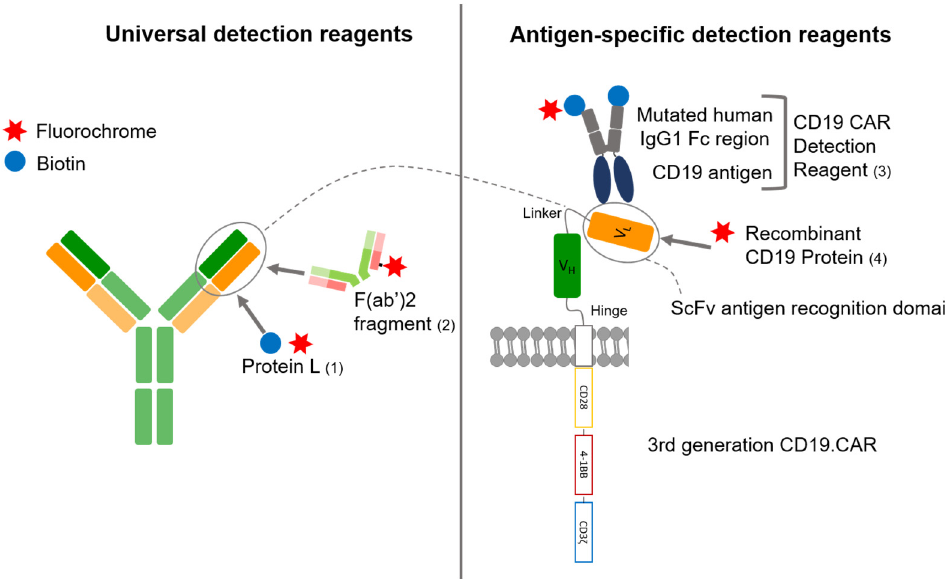
Figure 1. Binding mechanisms of the different CD19.CAR detection reagents. Universal detection reagents, Protein L (1) and F(ab’)2 fragment (2) are binding to the immunoglobulin light chain and to the Fab portion of the immunoglobulin. Antigen-specific detection reagents (3 and 4) are binding to the CD19 binding site of the scFv. The reagents are either directly conjugated to a fluorochrome as recombinant CD19 protein (4) and F(ab’)2 fragment (2) or are conjugated to biotin binding to an anti-biotin antibody or fluorochrome conjugated streptavidin in a second staining step as CD19.CAR detection reagent (3) and Protein L (1). The CD19.CAR consists of a CD3 ζ cytoplasmatic domain fused to the CD28 and 4-1BB costimulatory domains. The light and the heavy chain variable domains (VL and VH) separated by a linker are building the single chain variable fragment (scFv), which is linked via a hinge-region to the transmembrane